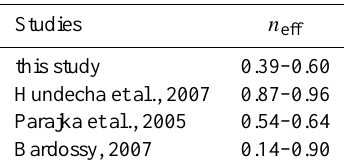
Table 8. Comparison of model performances in other studies mod- elling ungauged